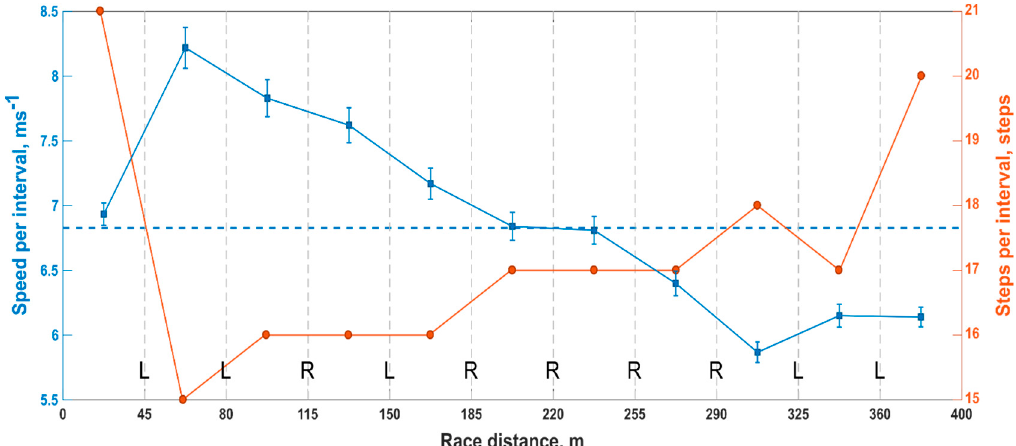
Figure 9. Average speed, number of steps, and leading leg analysis for each interval between hurdles within a single race. The average speed between all HC is shown with blue squares and the confidence interval with vertical solid lines. The blue horizontal dashed line corresponds to the average race speed. Also, the number of steps is depicted with orange circles and the leading leg at each HC (vertical grey dotted line) with R (right), or L (left).